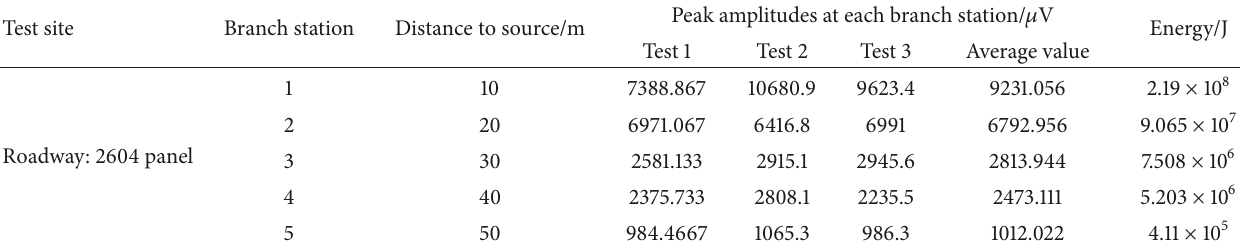
Table 2: Calculated peak amplitudes and energies at each branch station.